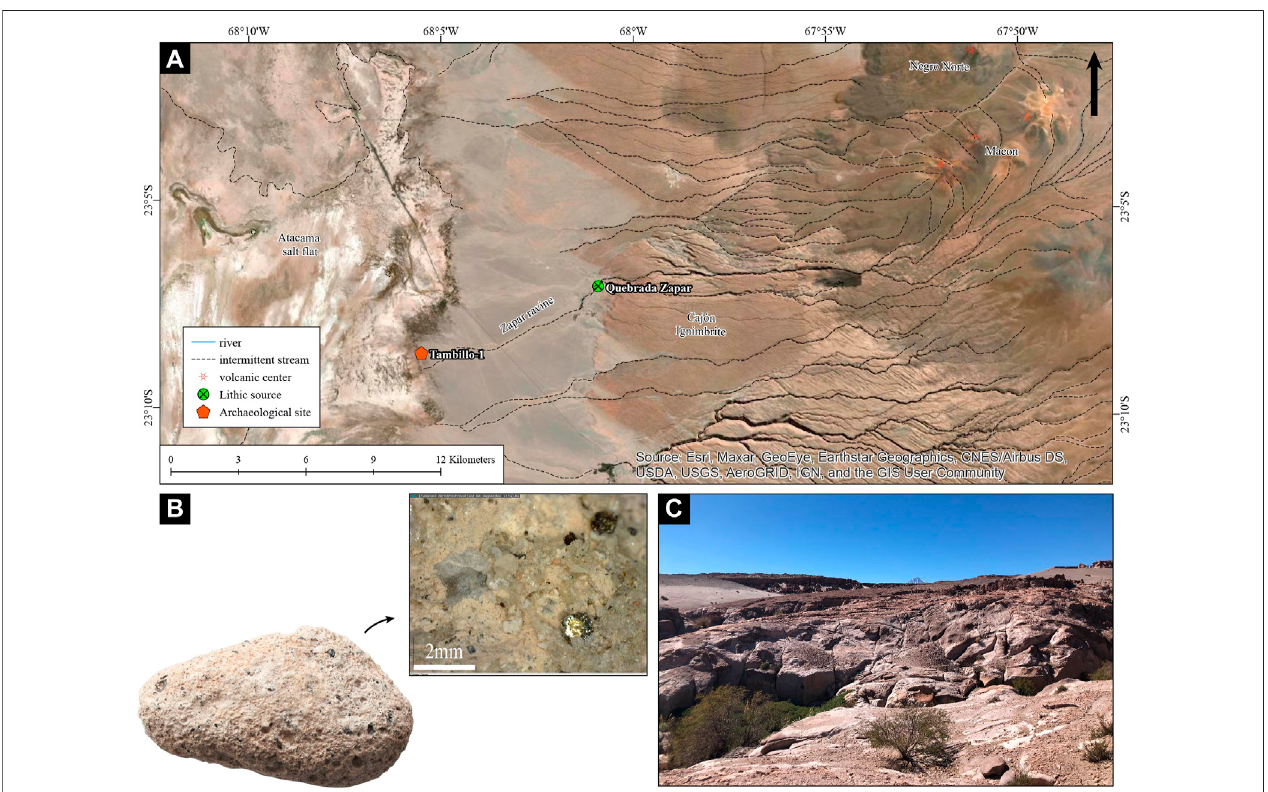
FIGURE 8 | Quebrada Zapar Source: (A) geological context; (B) pumice sample; (C) Zapar Ravine outcrops.